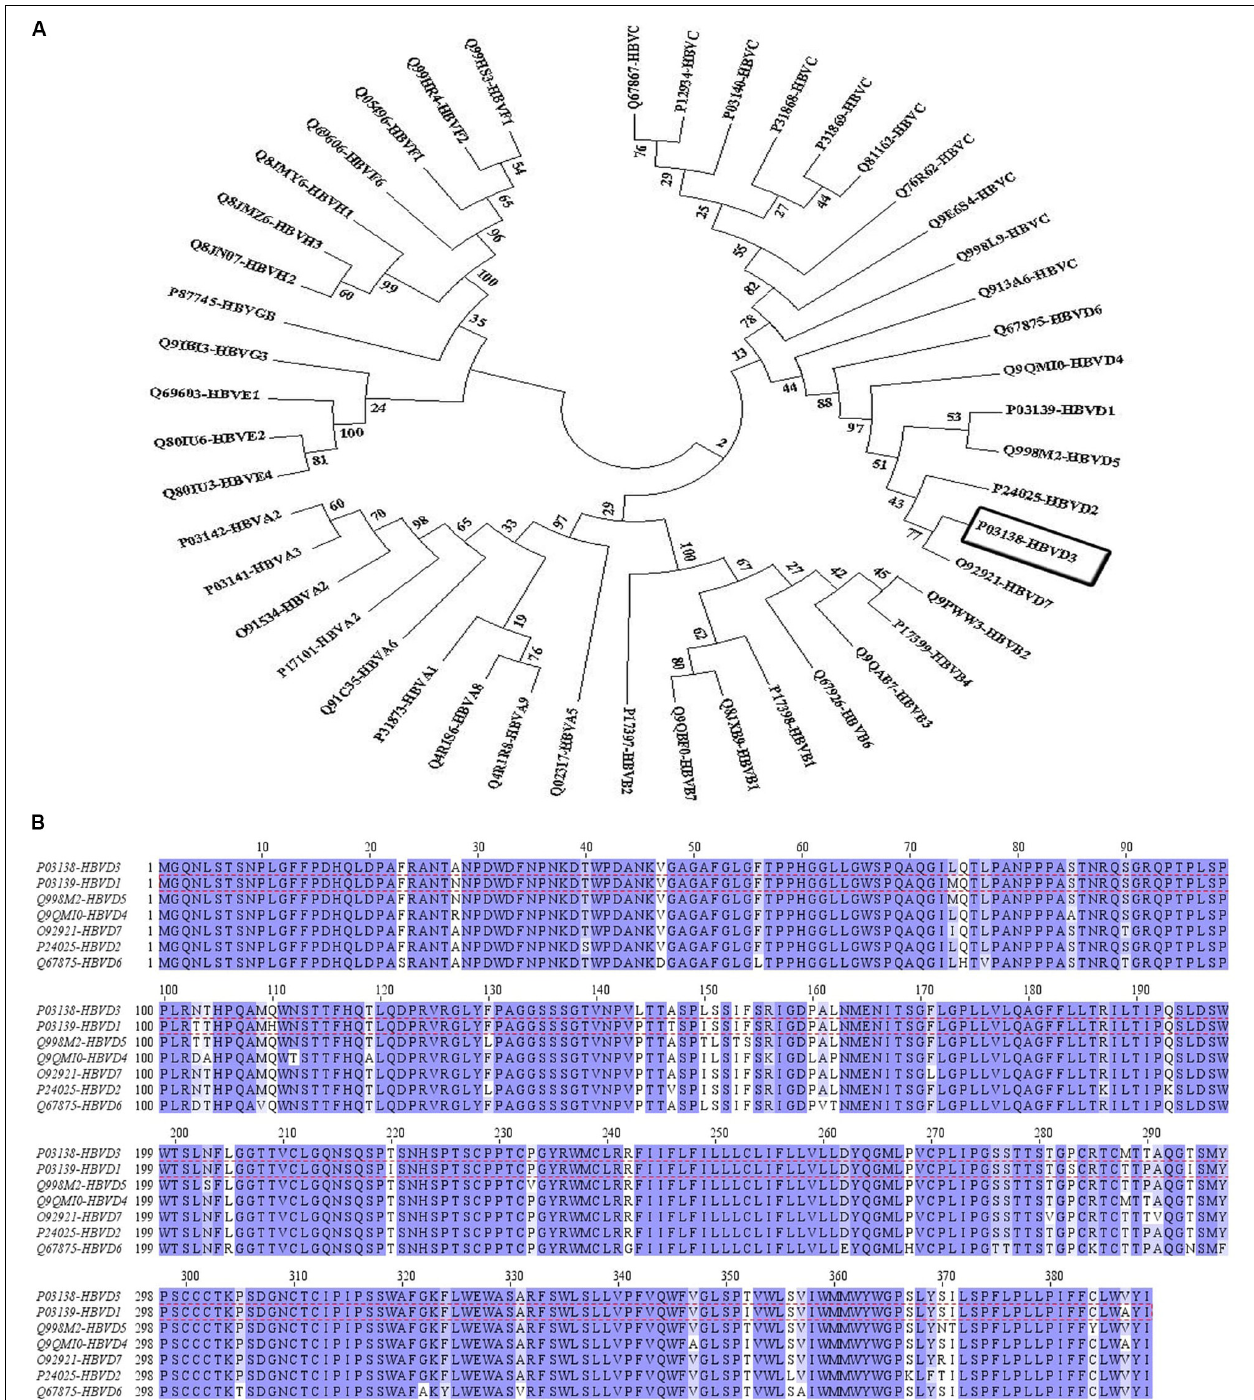
FIGURE 1 | The evolutionary relation was derived using the neighbor-joining method and multiple sequence alignment of hepatitis B surface antigen (HBsAg) among hepatitis B virus (HBV) genotype D. (A) The bootstrap consensus tree concluded from 1,000 replicates was taken to represent the evolutionary relation of the analyzed sequence of the large envelope protein of various genotypes of HBV. The percentage of replicate trees in which the associated proteins clustered together was visible above the branches . The evolutionary distances were computed using the Poisson correction method. The analysis involved 47 amino acid sequences. Evolutionary analyses were conducted in MEGA7. (B) The sequences have been colored by conservation based on the Blosum62 matrix in Jalview. The most dominant genotype of HBsAg in Iran, genotype D1, is depicted by red dashed lines .